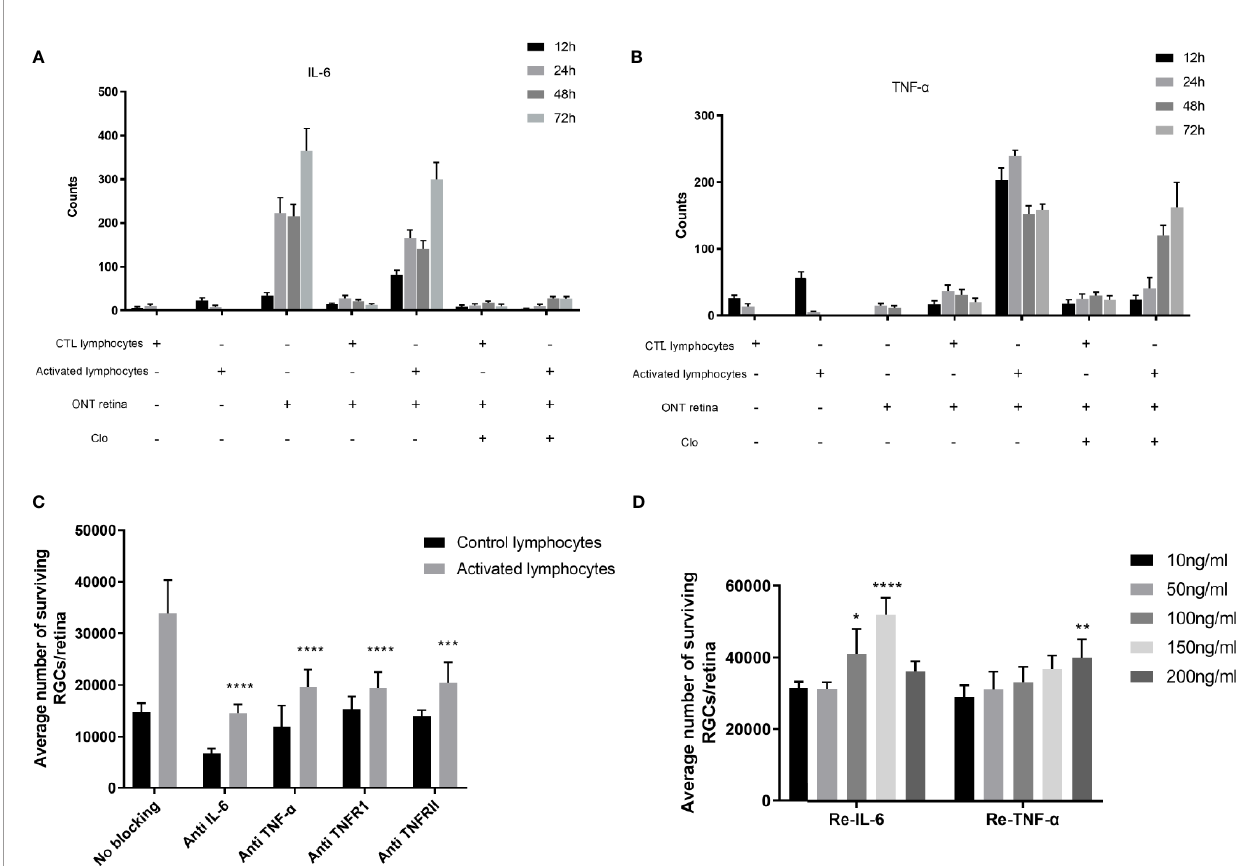
FIGURE 5 | Detection and effect of IL-6 and TNF- a (A, B) IL-6 and TNF- a detection by cytometric bead array in the culture medium following culture under different conditions for varying times. IL-6 was elevated in axotomized retinas only and with activated lymphocyte co-culture. Microglia/macrophage depletion reduced the secretion. TNF- a was secreted in the medium of retinas and was slightly suppressed in co-culture with activated lymphocytes in the fi rst 24 h but returned to peak afterward following microglia/macrophage depletion. (C) Compared to non-blocked activated lymphocyte co-culture, antibodies against IL-6, TNF- a , TNFR1, and TNFR2 reduced RGC viability. (D). Recombinant IL-6 and TNF- a increased the RGC viability in a dose-dependent manner (n=4-5 for each group). * P < 0.05, ** P < 0.01, *** P < 0.001, **** P <